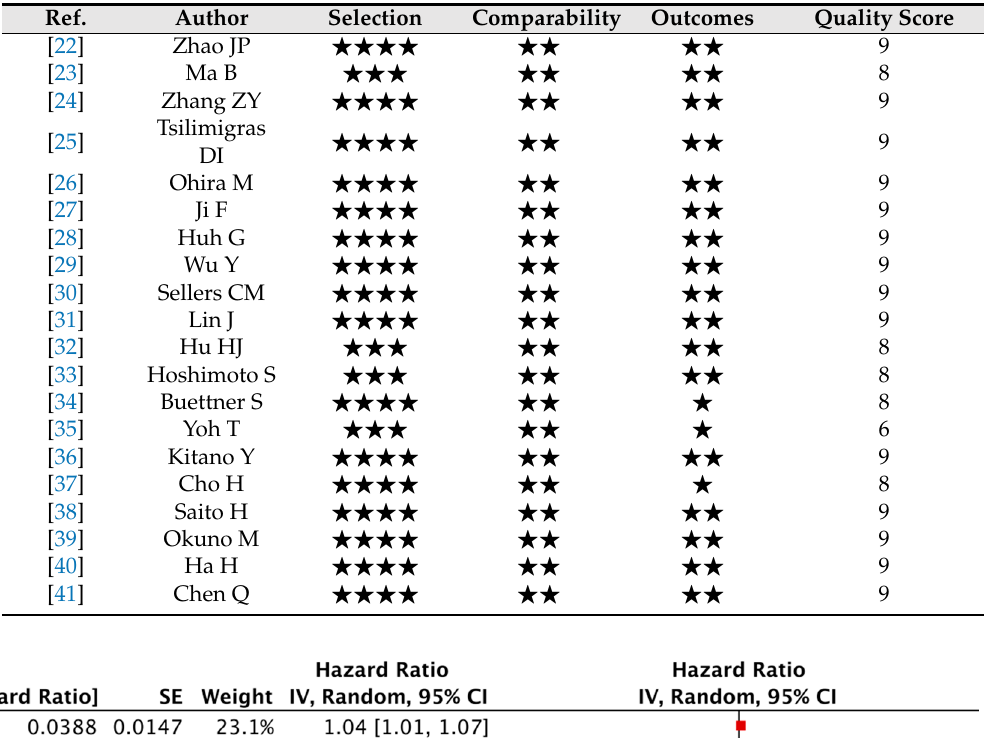
Table 2. Quality of included cohort studies evaluated by modified Newcastle–Ottawa scale. The quality of the included studies was assessed under six items of Hayden et al. [21] All included trans- lational studies reporting oncological outcomes were evaluated in accordance with the Newcastle– Ottawa scale. The maximum score of the scale is nine points, with studies being categorized as low (0–3 points), moderate (4–6 points), or high quality (7–9 points). Ref.